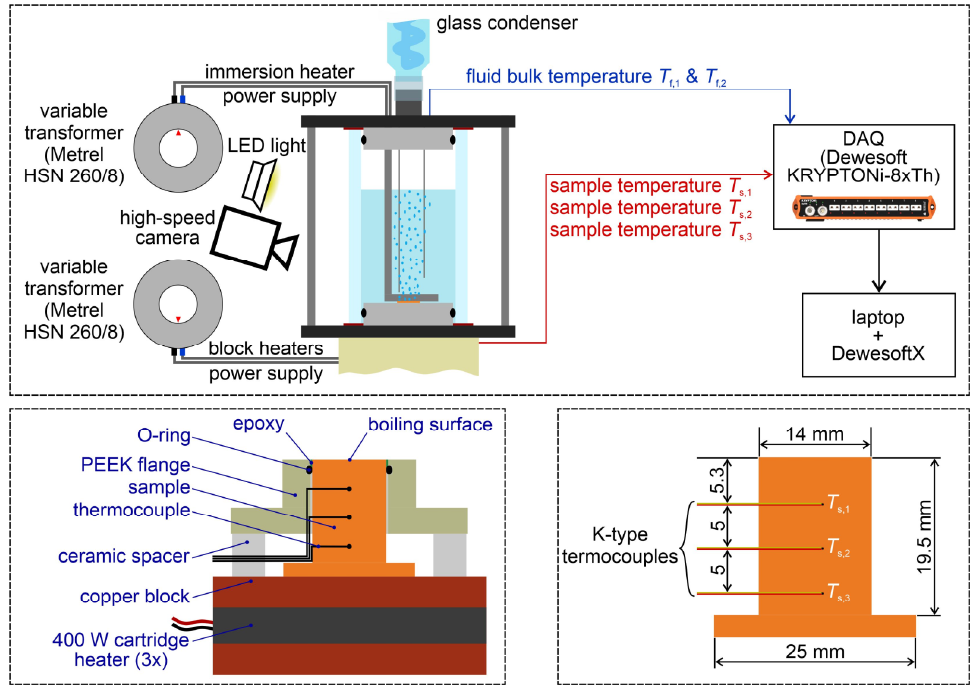
Figure 2. Experimental setup ( top ), heating block and sample assembly ( bottom left ) and sample dimensions including thermocouple locations ( bottom right ).